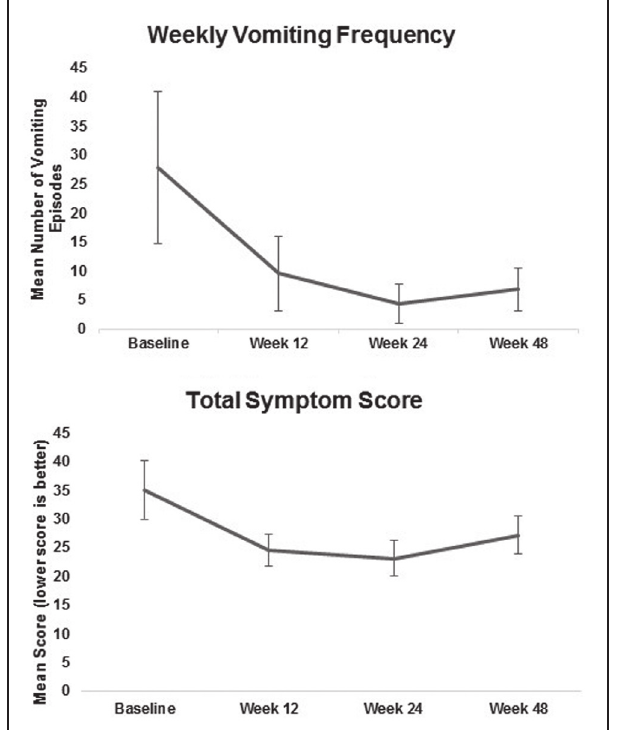
Figure 2) Gastroparesis symptoms measures